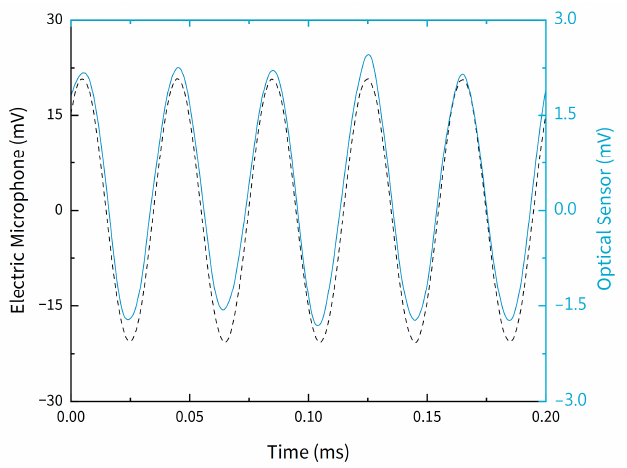
Figure 6. Time domain response of the sensor and the electric microphone to an applied acoustic frequency of 25 kHz.